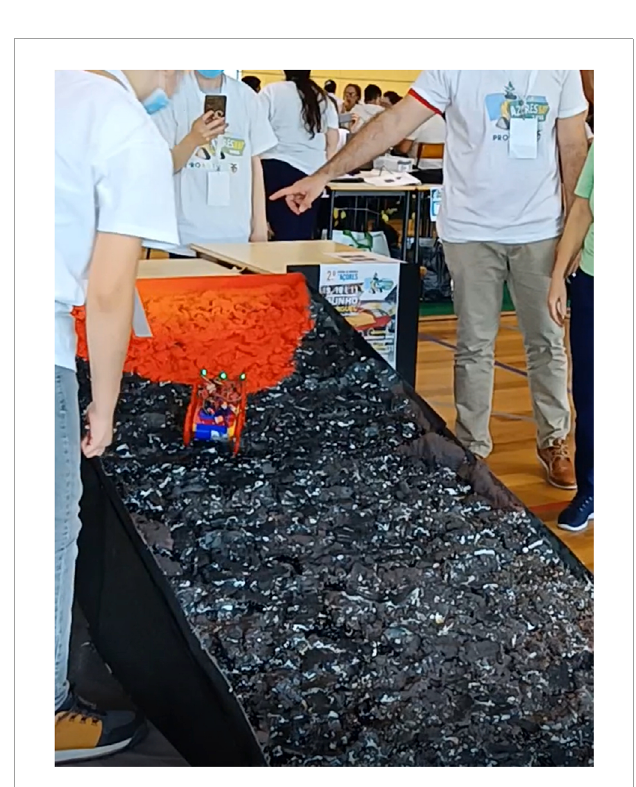
FIGURE 8 Wheg created by one of the